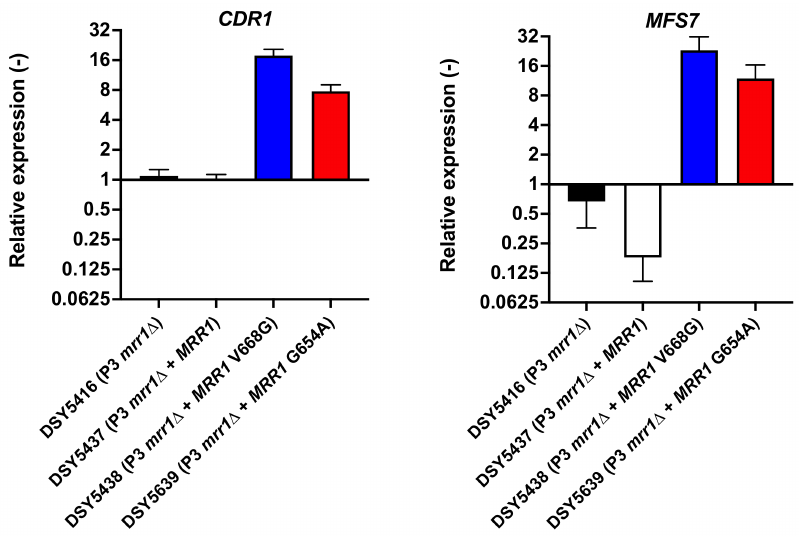
Figure 1. MRR1 GOF alleles trigger the upregulation of multidrug transporters CDR1 and MFS7 . qPCRs were performed as described in Material and Methods. Expression fold-changes were reported to the parent isolate DSY5416 for CDR1 and MFS7 expression patterns. Blue and red colors indicate the effect of MRR1 GOF mutations V668G and G654A,